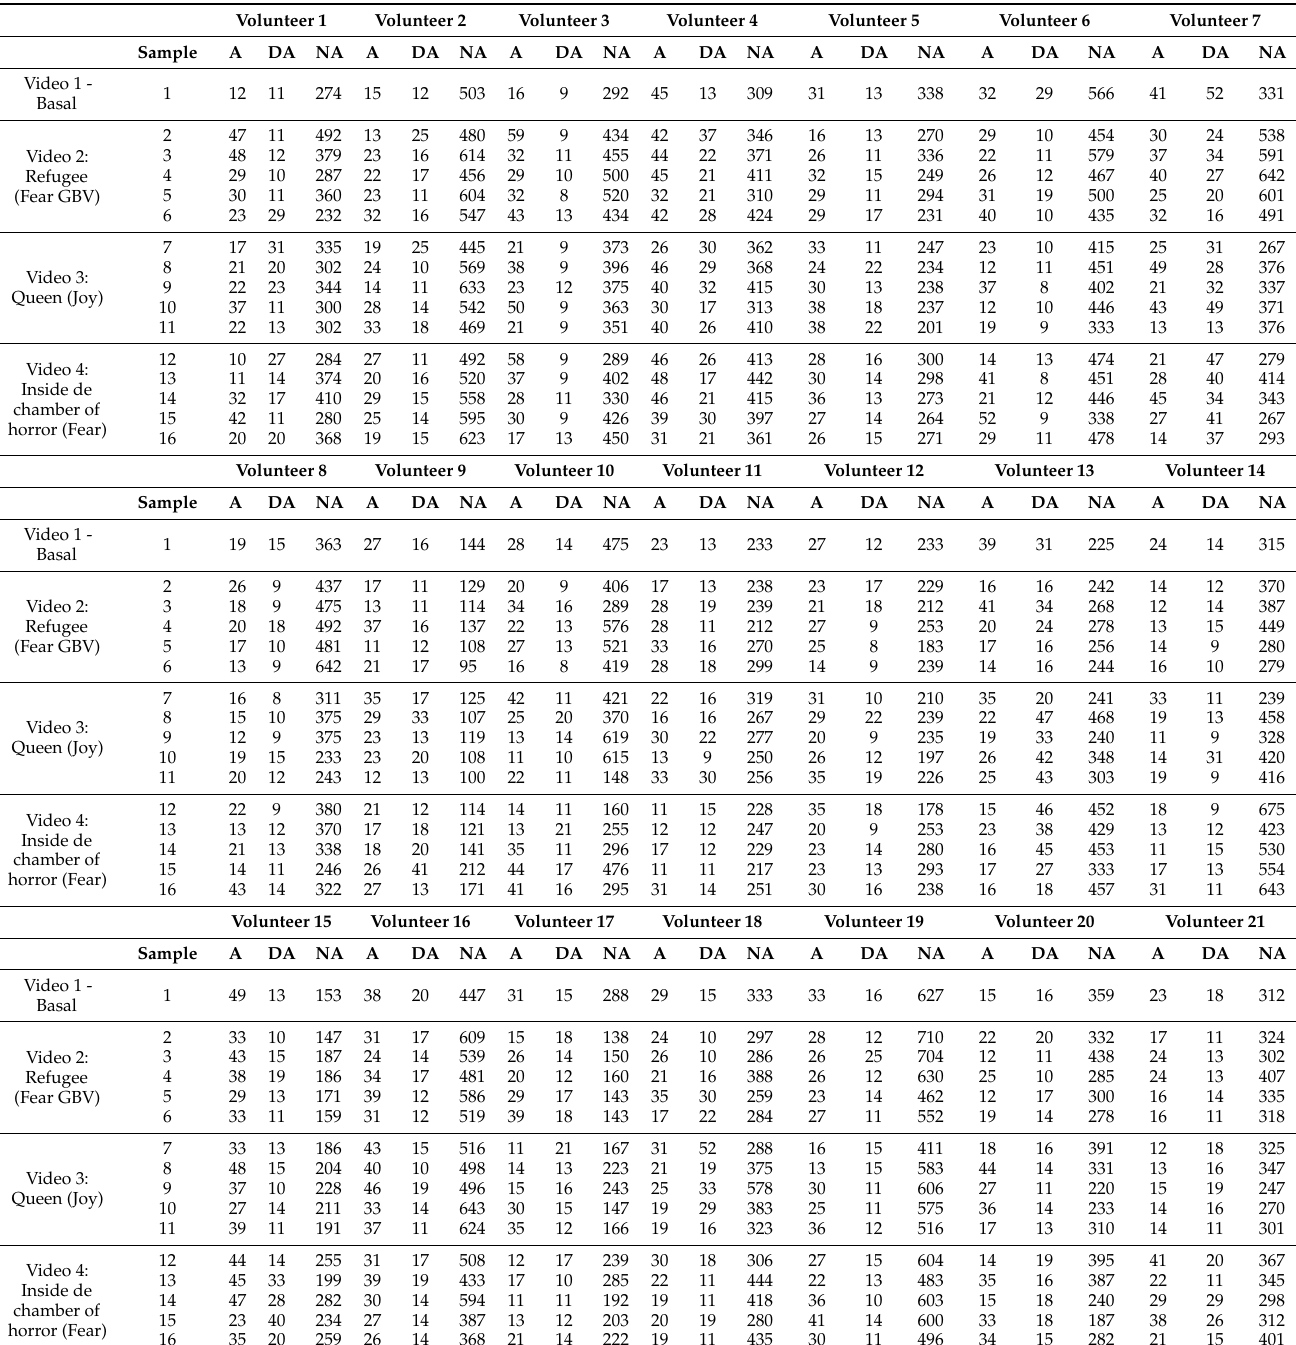
Table 5. Plasma catecholamine concentration levels for every volunteer for every sample (pg/mL), for adrenaline (A), dopamine (DA) and noradrenaline